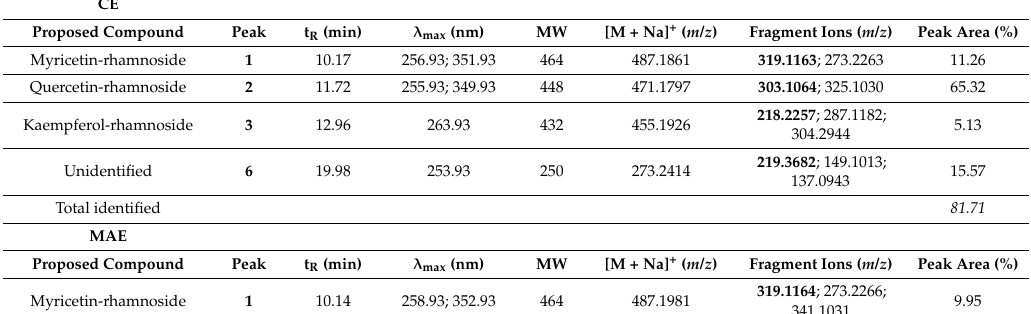
Table 2. Phenolic compounds detected in the leaf extracts obtained from Nectandra grandiflora Nees by LC-UV/ESI-HR-MS in the positive